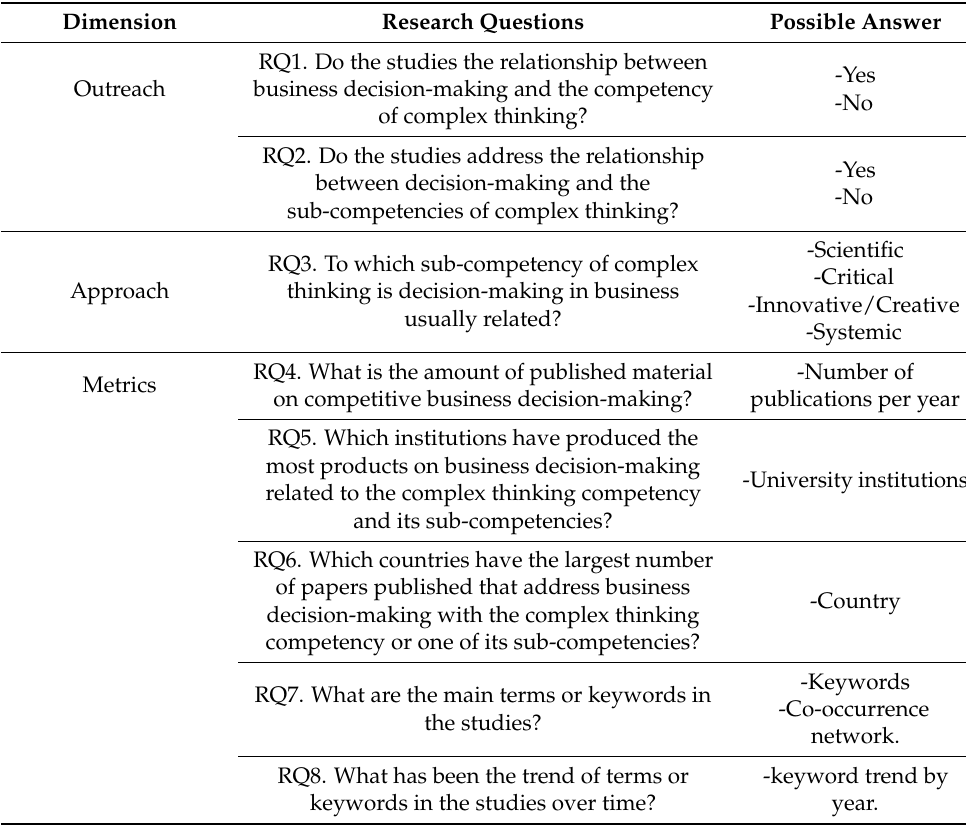
Table 1. Research questions and possible answers per dimension.